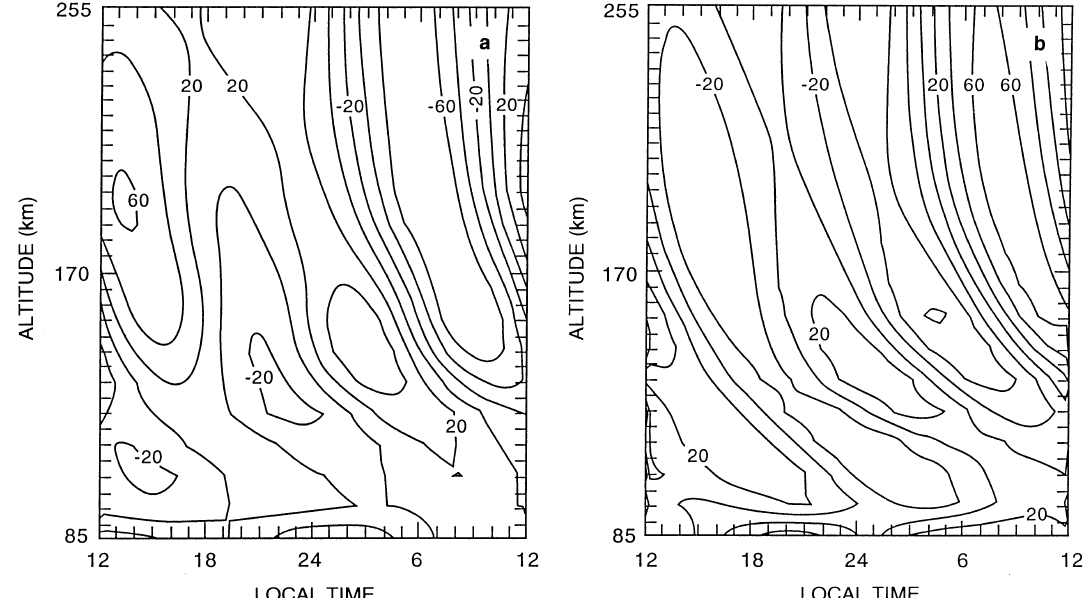
Fig. 3a, b. Height versus local time structures of a zonal wind and b meridional wind at 18 (cid:176)